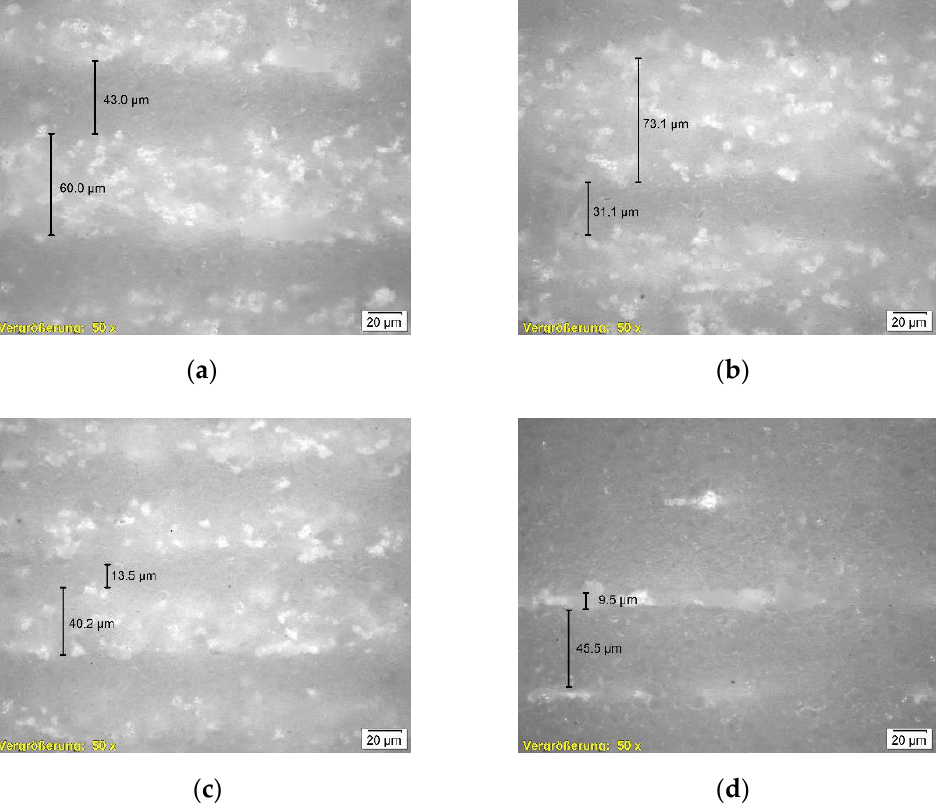
Figure 12. Microscopic images of selected samples (magnification 50 ×) depicting a microstructure split into two layers at similar proportions for ( a – c ). The visible structure in ( d ) shows a remarkable dense structure together with small areas of accumulated pores. ( a ) 100;1;3.4; ( b ) 100;3;4.2; ( c ) 50;1;4.2; ( d )